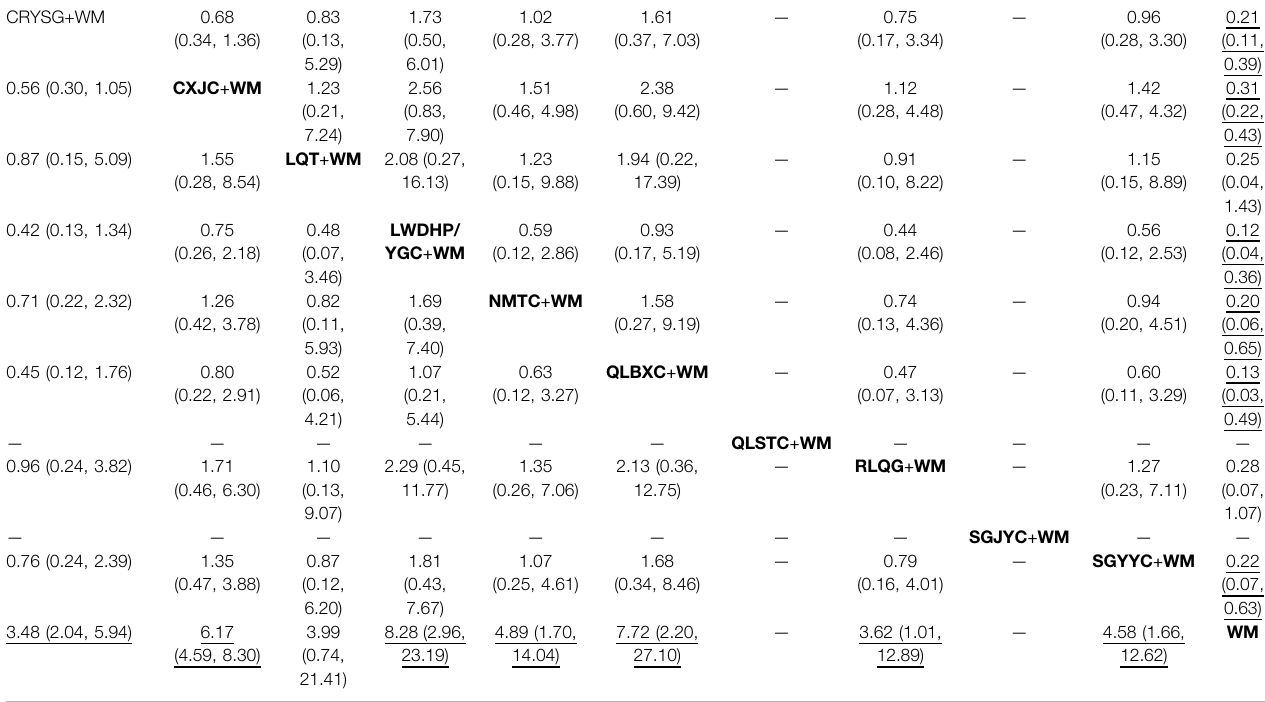
TABLE 4 | Odds ratios (95% CIs) of the clinical effective rate of CP/CPPS (right upper quarter) and SD (left lower quarter).